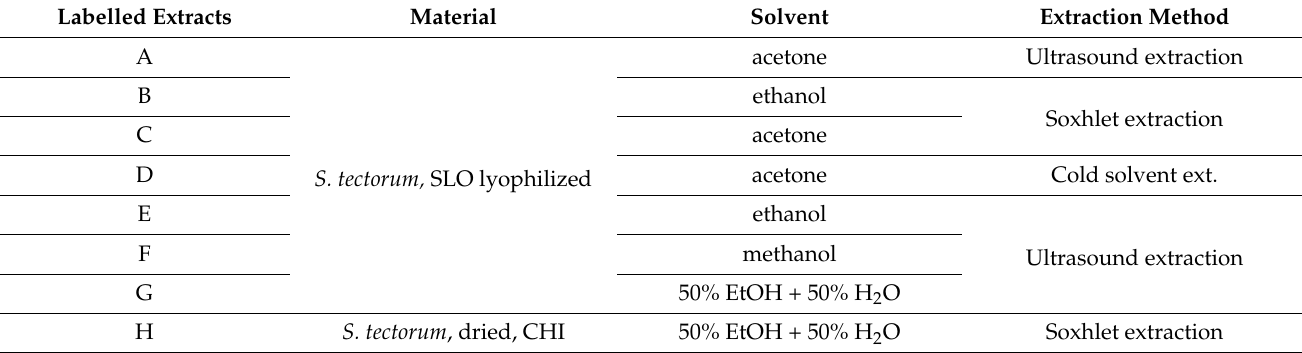
Table 1. Used extracts for metabolic activity assay on metabolic melanoma